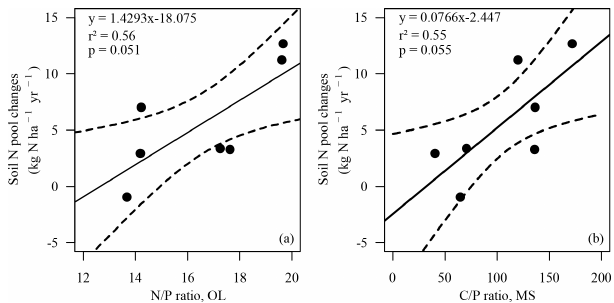
Figure 4. Soil N pool changes ( (cid:49) N S , kgNha − 1 yr − 1 ) versus N / P ratio in the organic layer (OL) (a) and versus the C / P ratio in the upper mineral soil (0–10cm) (MS) (b) . Solid line: regression line. Dotted lines: confidence bands of regression with p = 0 . 90. Spear- man’s rank correlation (a) r Spear = 0 . 86, p < 0 . 05; (b) r Spear = 0 . 79, p = < 0 . 05.